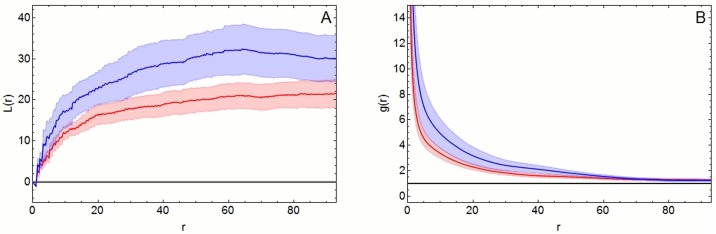
A, B. Pooled L-functions (A) and pair-correlation functions (B). Both functions show a higher deviation from complete spatial randomness (CSR) point patterns (blue line) in diabetic patients than in controls (red line). The respective Monte-Carlo envelopes (blue and red areas) in A are separated for the most part, while they are slightly superimposed in B. Results from studentized permutation test confirm these visual findings. A significant difference between the groups was noted for L functions (p = 0.026) but not for pair-correlation functions (p = 0.056).